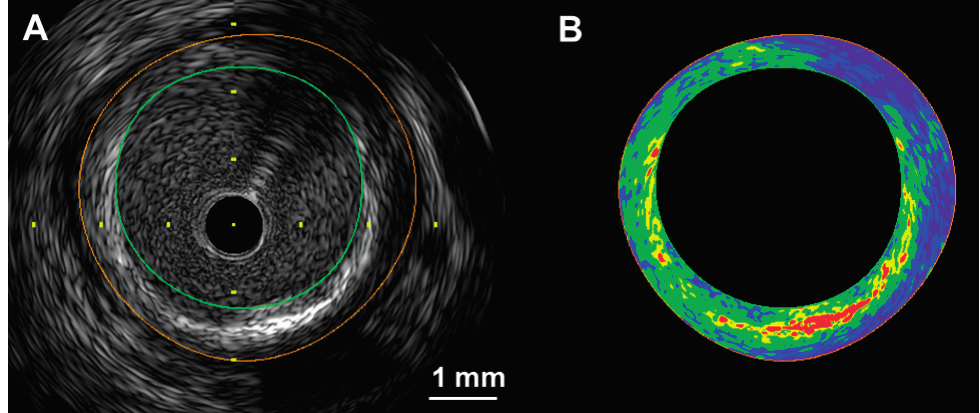
Figure 2. A two-dimensional color-coded map of the coronary arterial plaque. Conventional IVUS images and IB-IVUS color-coded maps were displayed side-by-side on a monitor. Calculation of the relative area of each tissue characteristic was automatically performed by computer software. ( A ) Conventional IVUS image; ( B ) Two-dimensional color-coded map (red: calcification, yellow: dense fibrosis, green: fibrosis, blue and purple: lipid